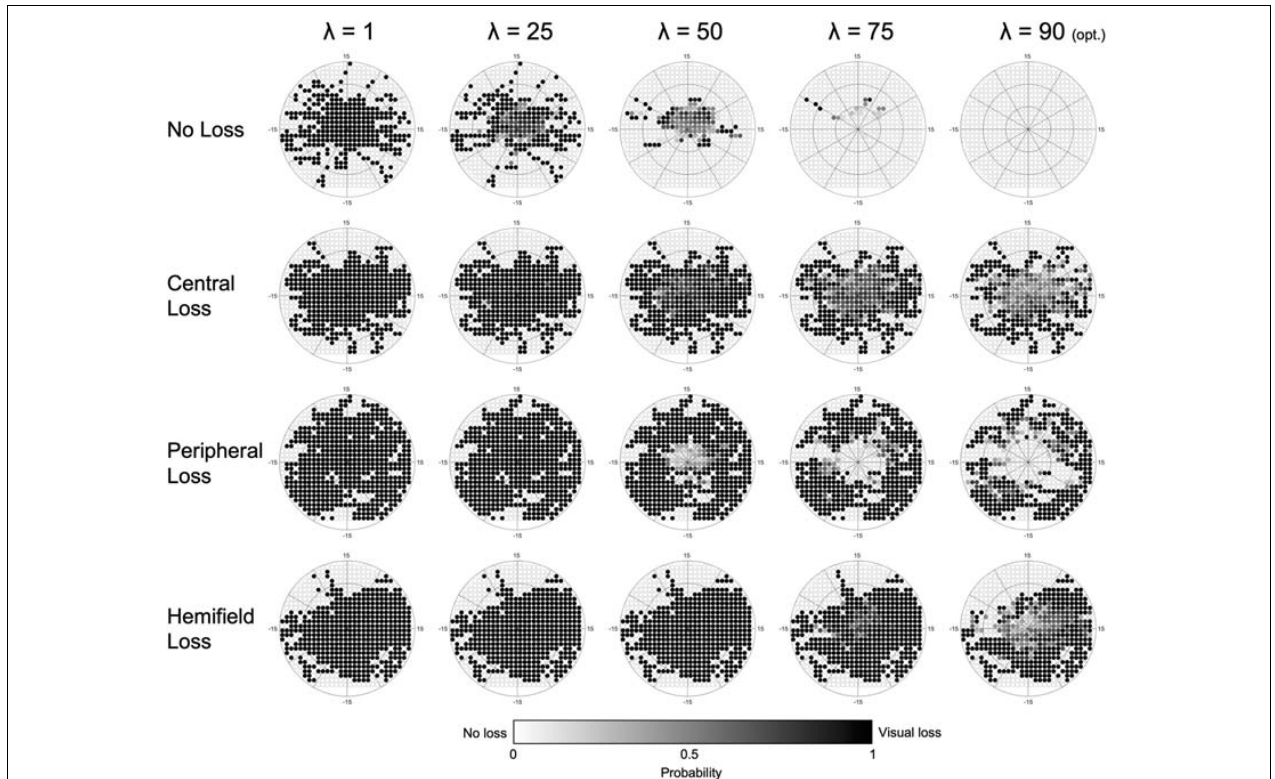
FIGURE 7 | Example of the effect that adjusting the λ parameter has on a single participant, across all conditions. As the optimal λ (90) is approached, the number of false positives across all conditions is minimized. Darker colors indicate a higher probability of that point being affected by visual loss (white = 0%, black =